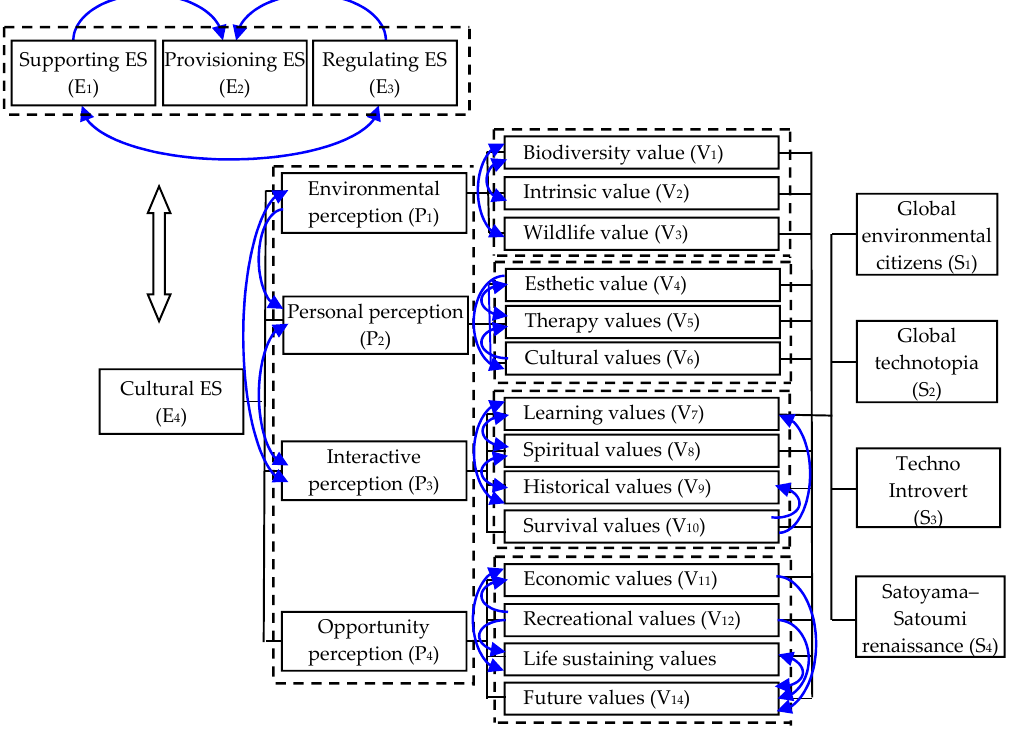
Figure 3. Influential relations and evaluation structures.